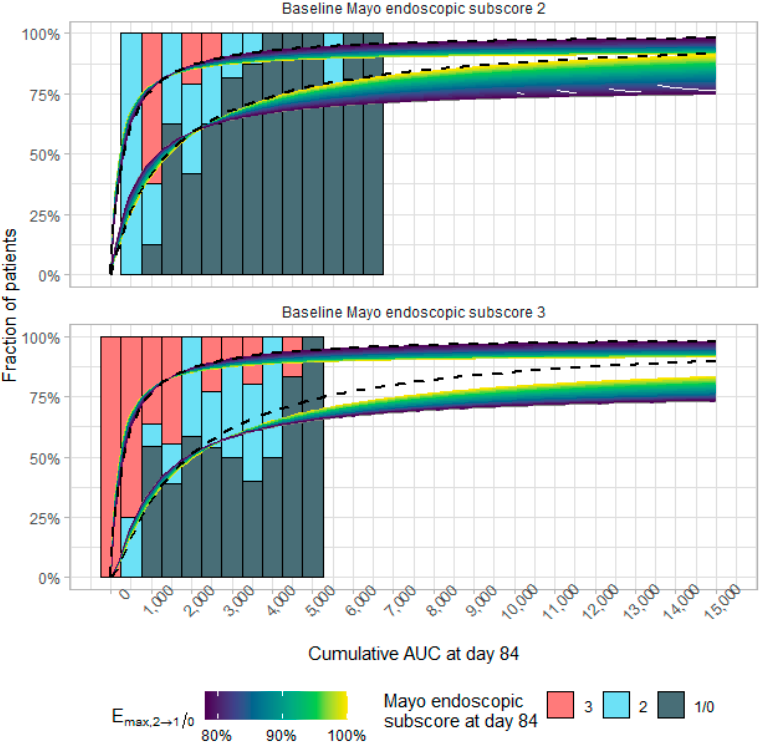
Figure 1. Exposure–response dataset (bars), binned per cumulative area under the curve (AUC) at day 84 and categorized according to Mayo endoscopic subscore at day 84, and corresponding simulated exposure–response models (lines representing the fraction of patients achieving a Mayo endoscopic subscore ≤ 1 [lower line] and ≤ 2 [upper line]). The original exposure–response model of Dreesen et al. [18] is shown as a black dashed line (E max,3 → 2 and E max,2 → 0/1 are both 100%). Colored lines represent models at ∆ 2LL = 3.84 with E max,3 → 2 93% and different E max,2 → 1/0 values. All presented models fit the exposure–response dataset equally well (at α = 0.05) but have different predictions outside the observed exposure